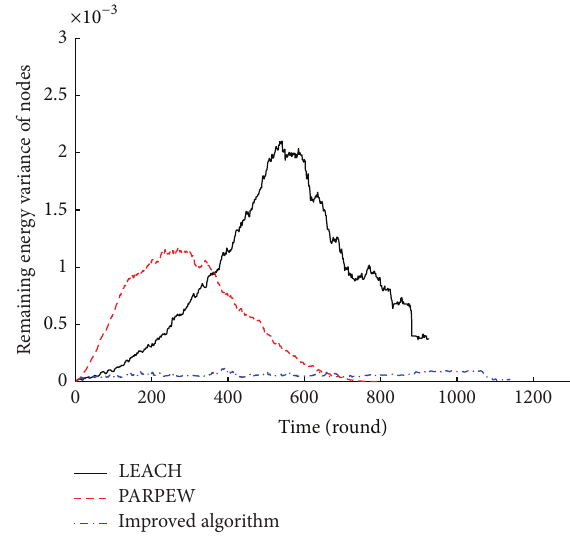
Figure 8: Comparison of the remaining energy